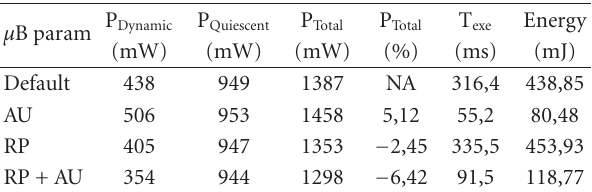
figurations compared to the reference system are presented for the DIALIGN algorithm. Adding an AU improves the execution time by 5% while increasing the overall